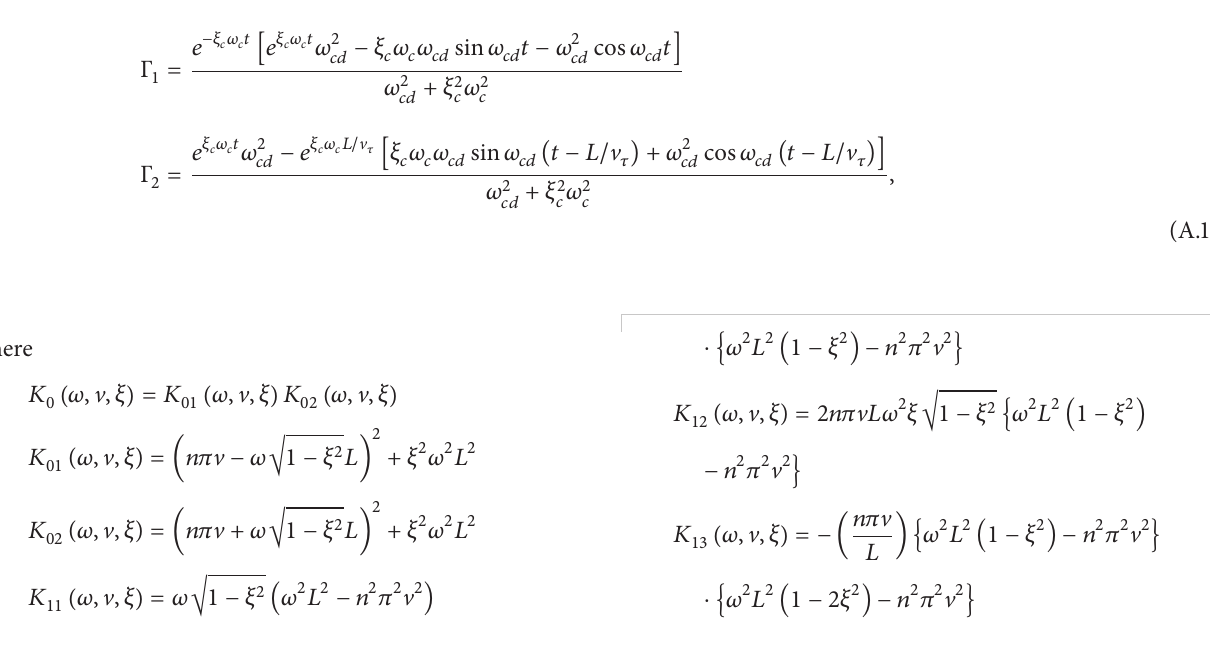
Figure 12: Comparison of the dynamic responses at 𝑥/𝐿 = 0.25 of a simply supported beam subjected to a stationary impulsive point transverse force applied at 𝑥/𝐿 = 0.5 obtained by Timoshenko beam theory and Bernoulli-Euler beam theory: (a) transverse displacement (𝑤) ; (b) shear angle (𝜓)